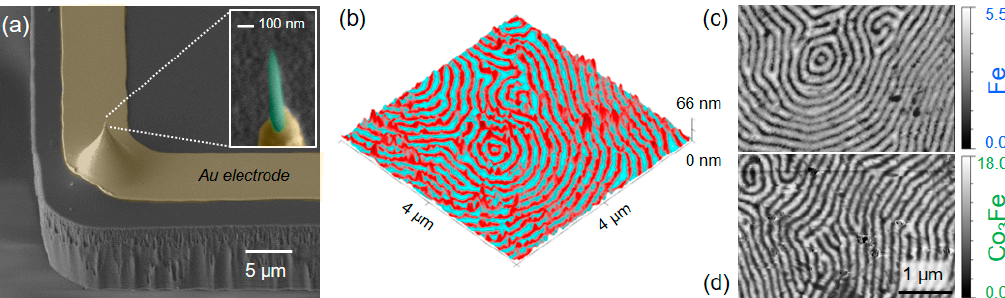
Figure 8. FEBID-based, high-performance MFM tips. ( a ) shows a tilted SEM side view of a pre-structured, self-sensing cantilever, modified by a magnetic Co 3 Fe tip via 3D-FEBID at 20 keV / 13 pA. Such tips reveal typical diameters and apex radii well below 100 nm and 10 nm, respectively. ( b ) shows a 3D height image with the MFM signal as overlay, taken from a Co / Pt multilayer structure with perpendicular magnetic anisotropy. ( c , d ) show MFM phase images from the same sample, however, acquired via Fe and Co 3 Fe FEBID tips, with similar morphologies. A closer look reveals that MFM tips from Co 3 Fe reveal much stronger phase contrasts by a factor of more than three, while lateral resolution is also improved to the sub-20 nm regime. Images are courtesy of GETec Microscopy [95] ( a – c ) and Michael Huth ( d ). Copyright 2019.